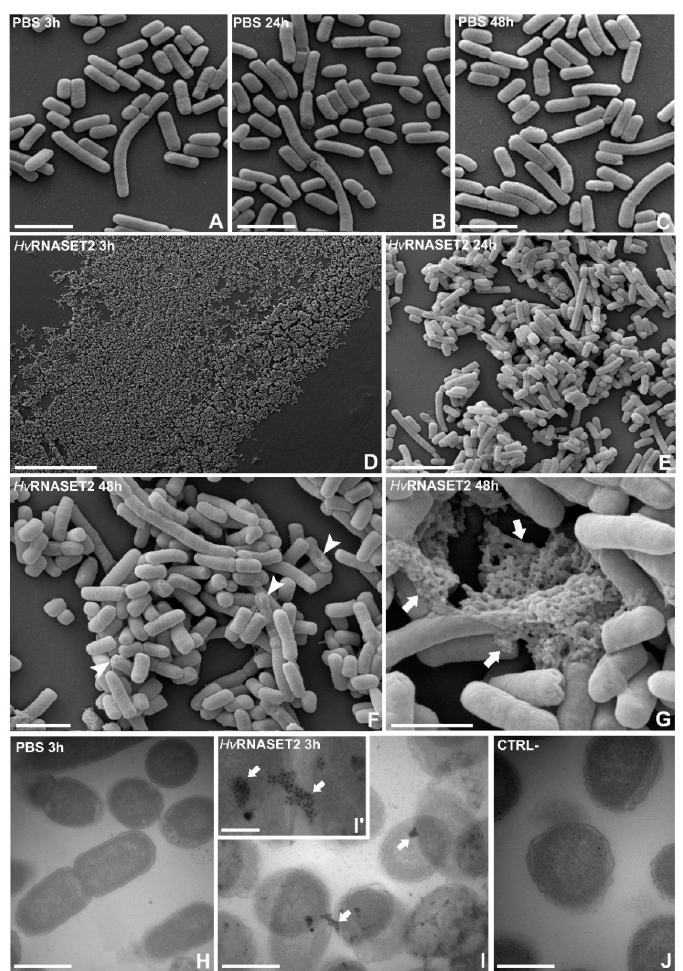
Figure 4. SEM and immunogold analyses. ( A – C ) With SEM, E. coli treated with PBS were randomly distributed on the analyzed surfaces, after 3 h ( A ), 24 h ( B ) and 48 h ( C ). ( D – G ) However, the incubation with rHvRNASET2 induced a strong bacterial agglutination already 3 h after treatment ( D ). Moreover, in particular after 24 h ( E ) and 48 h ( F , G ) from incubation, bacterial aggregates were clearly visible, and cell membranes appeared damaged ( F ) (arrowheads), releasing the cytoplasmatic content into the external environment ( G ) (arrows). ( H – J ) Immunogold at TEM. Immunogold assays, performed 3 h after incubation, indicate that rHvRNASET2 is specifically located on the E. coli outer bacterial surface ( I , I’ ) (arrowheads). No signals were detected in PBS samples ( H ) or in negative control experiments ( J ), in which the primary antibody was omitted. In particular ( I’ ), many gold particles were detectable, suggesting the direct interaction of Hv RNASET2 with bacterial cell components (arrow). Scale bars: ( A – C , F ) 2 µm; ( D ) 50 µm; ( E ) 5 µm; ( G ) 1 µm; ( H–J ) 0.5 µm; ( I’ ) 100 nm.